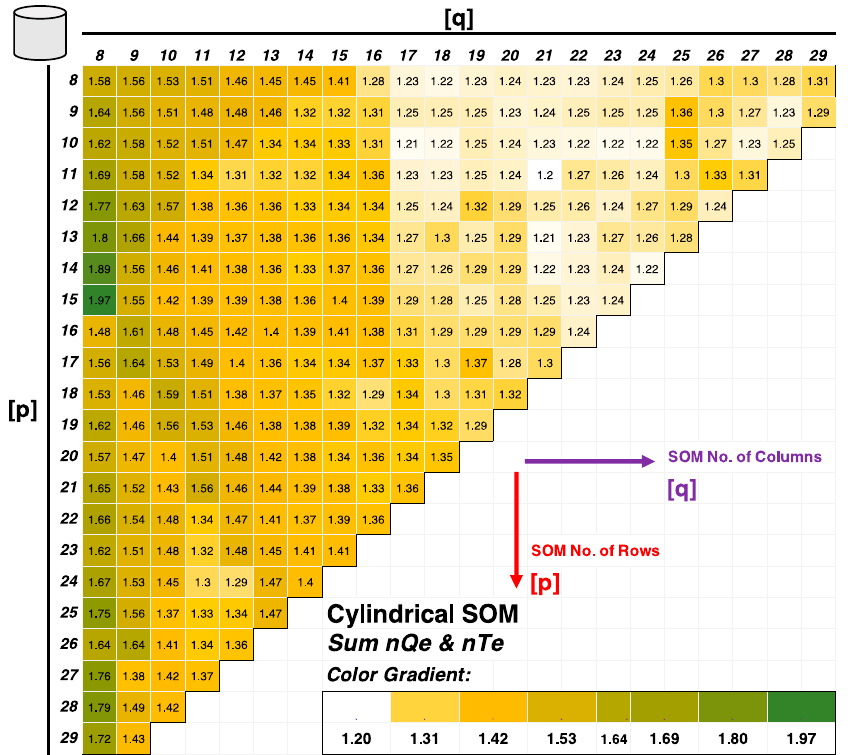
Figure 6. Sum of normalized topographic error (Te) and normalized quantization error (Qe) for cylindrical SOM in hexagonal lattice at number of rows and number of columns of the SOM lattice.